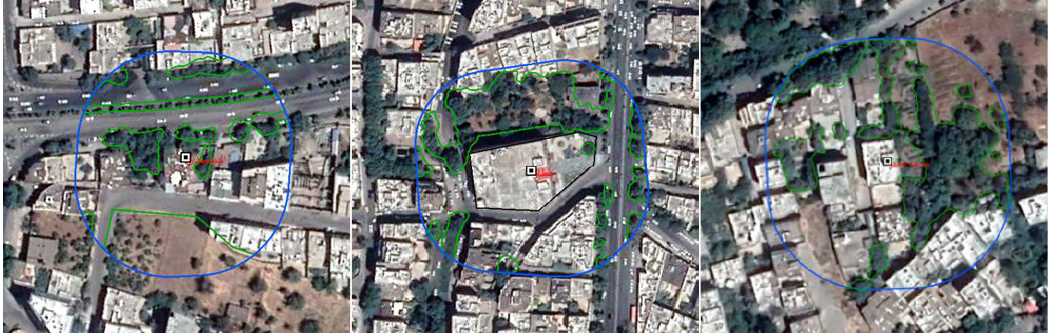
Fig. 4. Sample images of three evaluated